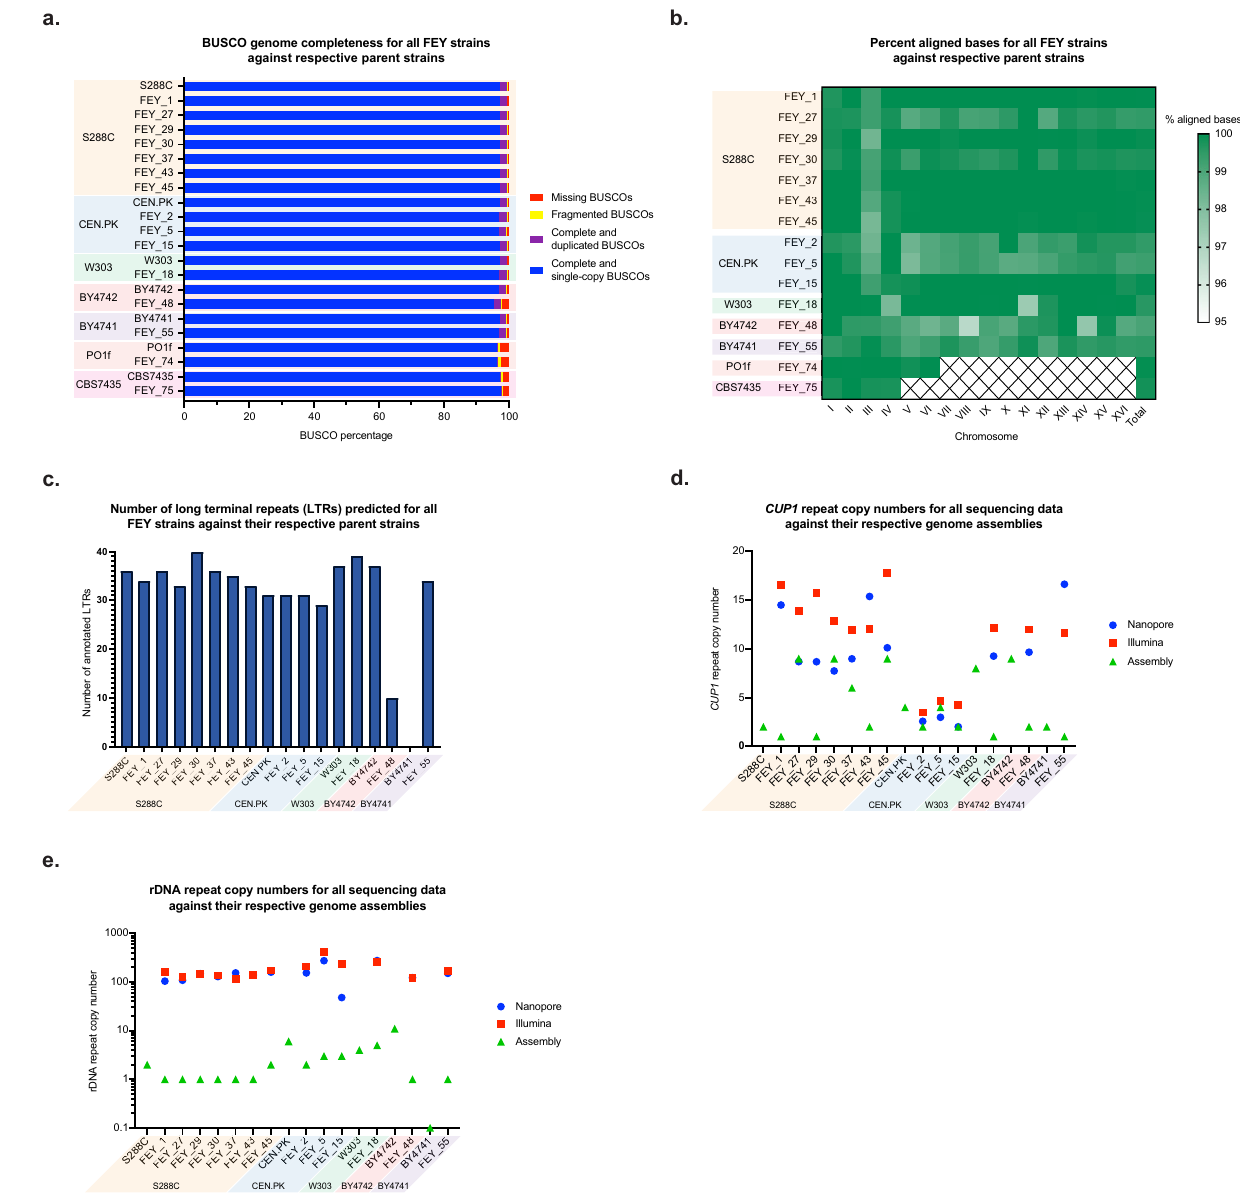
Fig. 3 Whole genome assembly quality for the panel of engineered yeast strains. a BUSCO genome completeness score for all engineered yeast genome assemblies and their respective reference parent strain genome assemblies. b Percentage of aligned bases for each chromosome of the reference parent strain assemblies captured by the engineered yeast assemblies. We could not determine the 16 chromosomes for the reference BY4741 assembly due to its discontiguity, so the FEY_55 assembly was compared to the BY4742 reference assembly. c The number of long terminal repeats (LTRs) predicted by LTRpred for all engineered S. cerevisiae genome assemblies and their respective reference parent strain genome assemblies. d The approximate copy number of CUP1 repeats in the genome assembly, raw Nanopore reads, and raw Illumina reads for all engineered S. cerevisiae strains, along with the CUP1 copy number in the respective reference parent strain assemblies. e The approximate copy number of rDNA repeats in the genome assembly, raw Nanopore reads, and raw Illumina reads for all engineered S. cerevisiae strains, along with the rDNA copy number in the respective reference parent strain assemblies. These are also tabulated in Supplementary Table